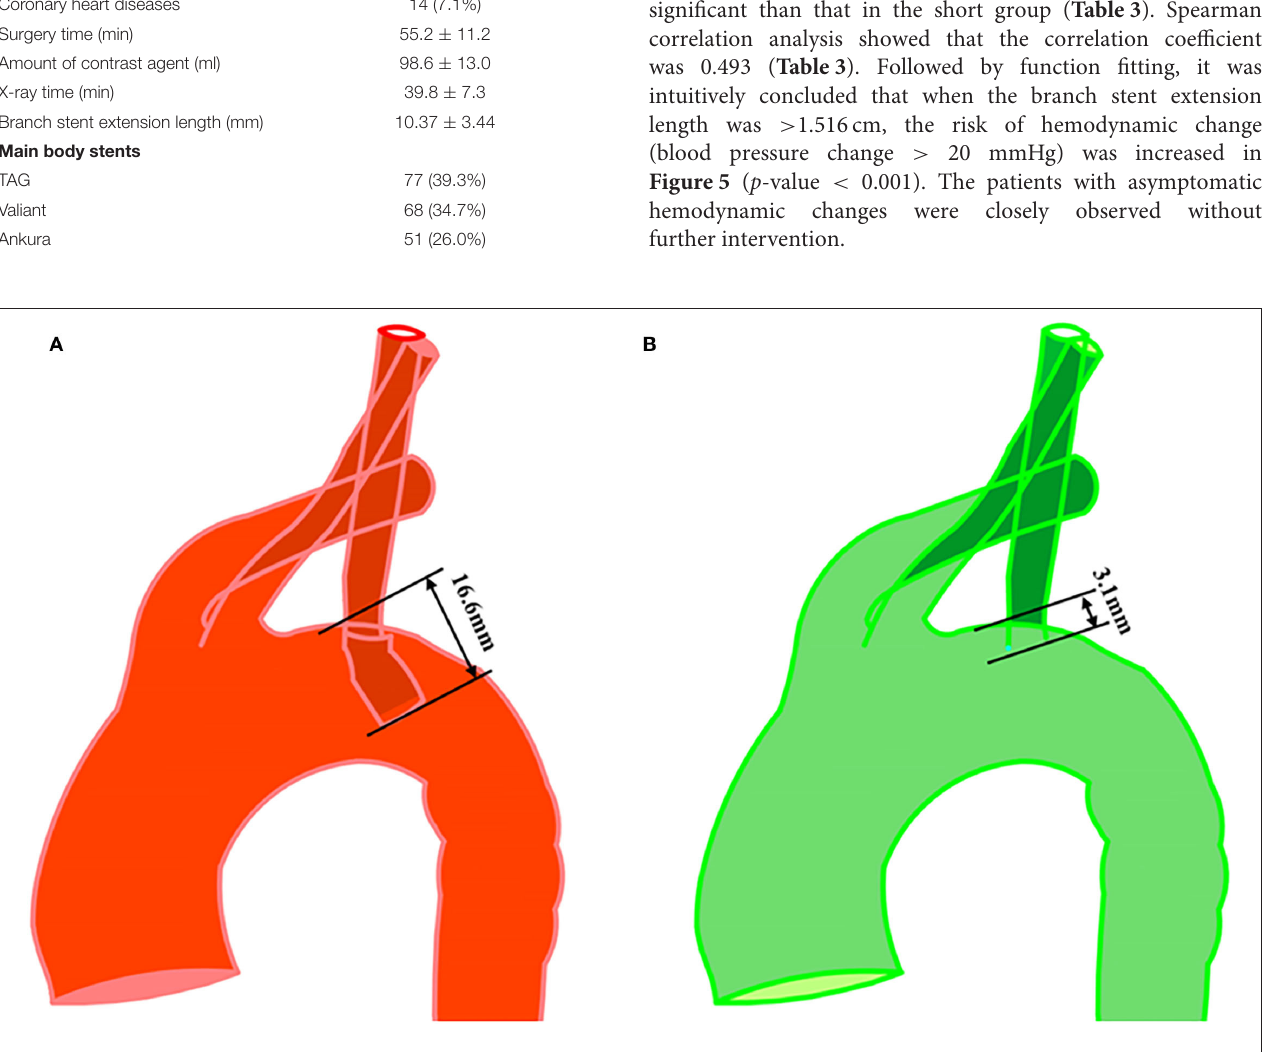
Frontiers in Cardiovascular Medicine |